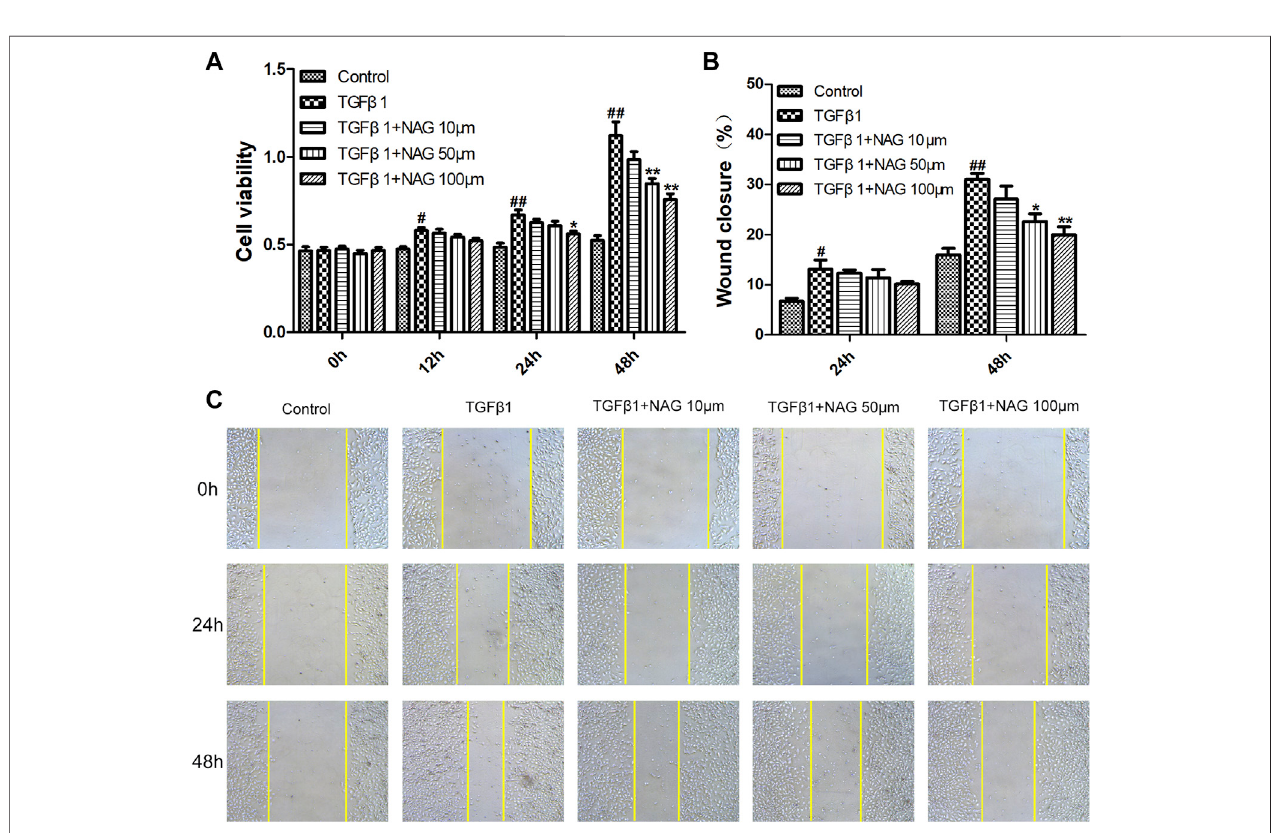
FIGURE 6 | Effects of naringin on proliferation and migration of HUVECs (A) Serum-starved HUVECs were incubated with TGF- β 1 (10 ng/ml) and the absence or presence of naringin (10, 50 and 100 μ mol/L) for 0, 12, 24, and 48 h (B,C) Serum-starved HUVECs were stimulated with TGF- β 1 (10 ng/ml) and the absence or presence of naringin (10, 50 and 100 μ mol/L) for 0, 24 and 48 h # p < 0.05, ## p < 0.01 vs. control; * p < 0.05, ** p < 0.01 vs. TGF β 1. n (cid:1) 3.